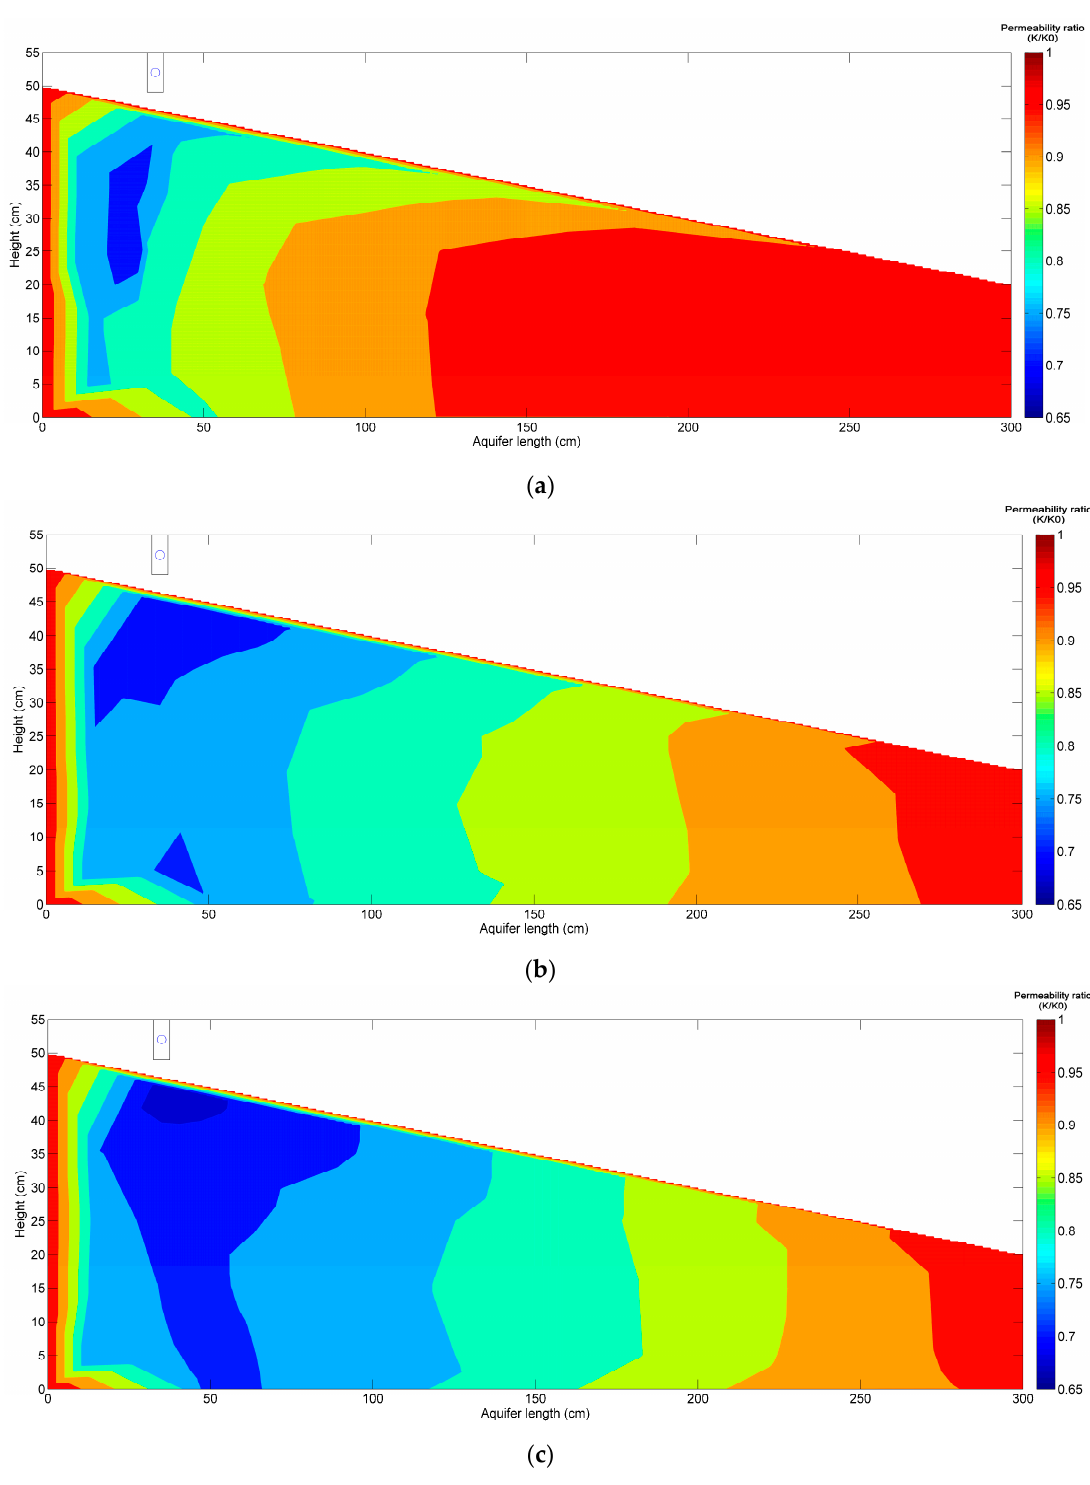
Figure 7. Spatial distribution of permeability estimated by Kozeny-Carman equation at the early ( a , t 1 ), middle ( b , t 2 ) and end ( c , t 3 ) stages of stormwater infiltration.